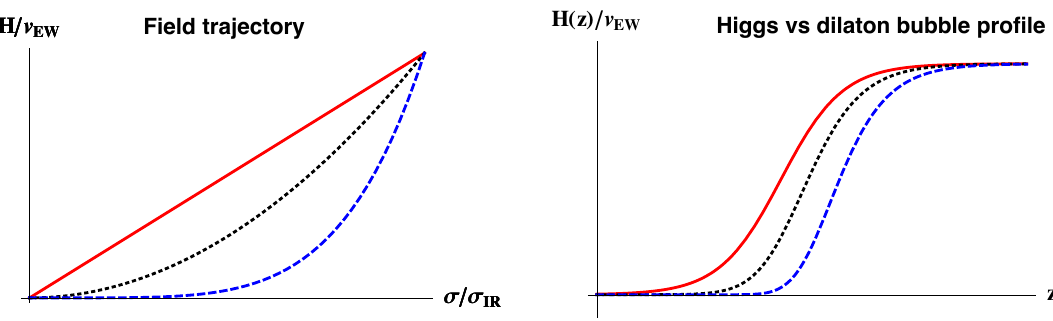
Figure 2 . Left: sketch of possible paths in the dilaton-Higgs (cid:12)eld space. The red solid line re(cid:13)ects the linear relationship (4.3) between the two VEVs. Right: the corresponding pro(cid:12)les of the (cid:12)elds along the bubble walls. The red solid line corresponds to the dilaton and Higgs bubble walls precisely overlapping and thus the linear relationship (4.3). For the dotted and dashed lines, the dilaton reaches its minimum before the Higgs does, which tends to attenuate the variation of the Yukawa couplings during the EW phase